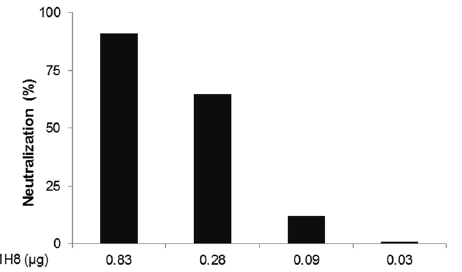
Figure 1. Effect of 1H8 on neutralization of the HCV genotype 2a virus in vitro . Hybridoma cell culture supernatant containing approximately 16.67 m g/mL of antibody 1H8 was collected and used in neutralization assay in a 3-fold dilution series [15]. Monoclonal mouse anti-E2 antibody 2C1 supernatant was used as a positive control. Percent neutralization was calculated based on an irrelevant mouse anti-CD4 antibody GK1.5 supernatant [15].